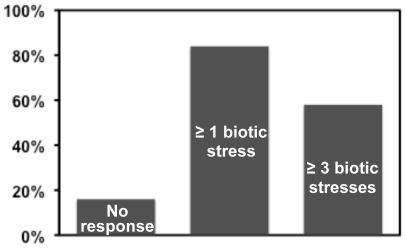
Percentage of the Arabidopsis homologs up-regulated by biotic stresses.